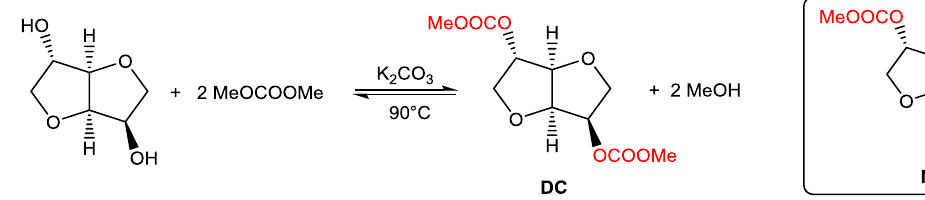
Scheme 1. Carboxymethylation of isosorbide via B Ac 2 pathway.